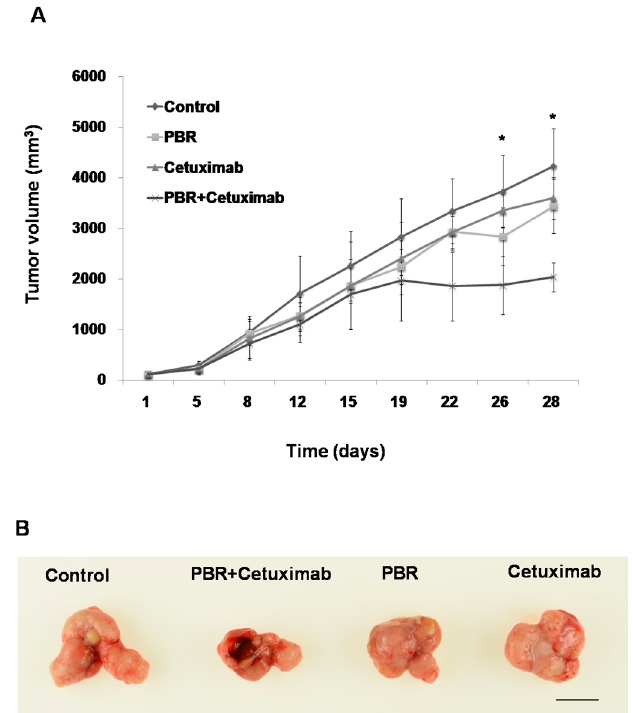
Figure 5. ( A ) Tumor volume changes in SW480 xenografted mice treated with control (saline), cetuximab (10 mg/kg in PBS), PBR extract (400 mg/kg/day), or the combination of cetuximab and PBR extract. Tumor volumes were compared to those of the control treatment, and a significant difference is denoted as * ( p < 0.05); ( B ) Representative SW480 xenograft tumors resected on day 26 showing the difference in tumor volumes between individual PBR extract or cetuximab treatment, and cetuximab and PBR extract combined treatment. Scale bar = 1 cm. Data are expressed as the mean ± standard error of the mean (SEM).